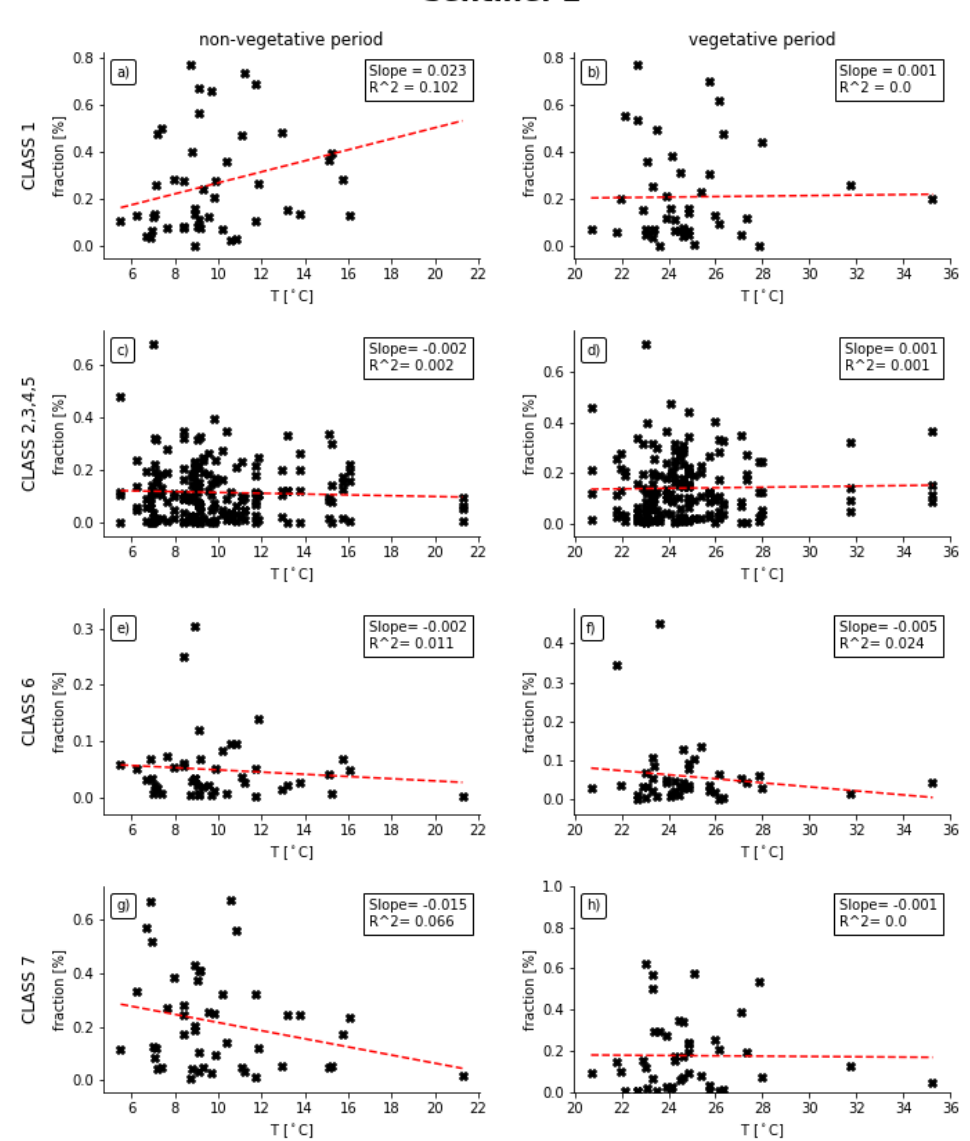
Figure 9. LCZ class fractions [%] computed into the 500 m buffer around the stations versus the measured air temperature at the stations. Air temperature measurements correspond to the hour of the Sentinel-2 imagery acquisition. Acquisition times are 13 January 2016 (non-vegetative period) and 22 May 2016 (vegetative period) both at 10:20 am GMT. Red Lines and text boxes show the results of the linear regression for each